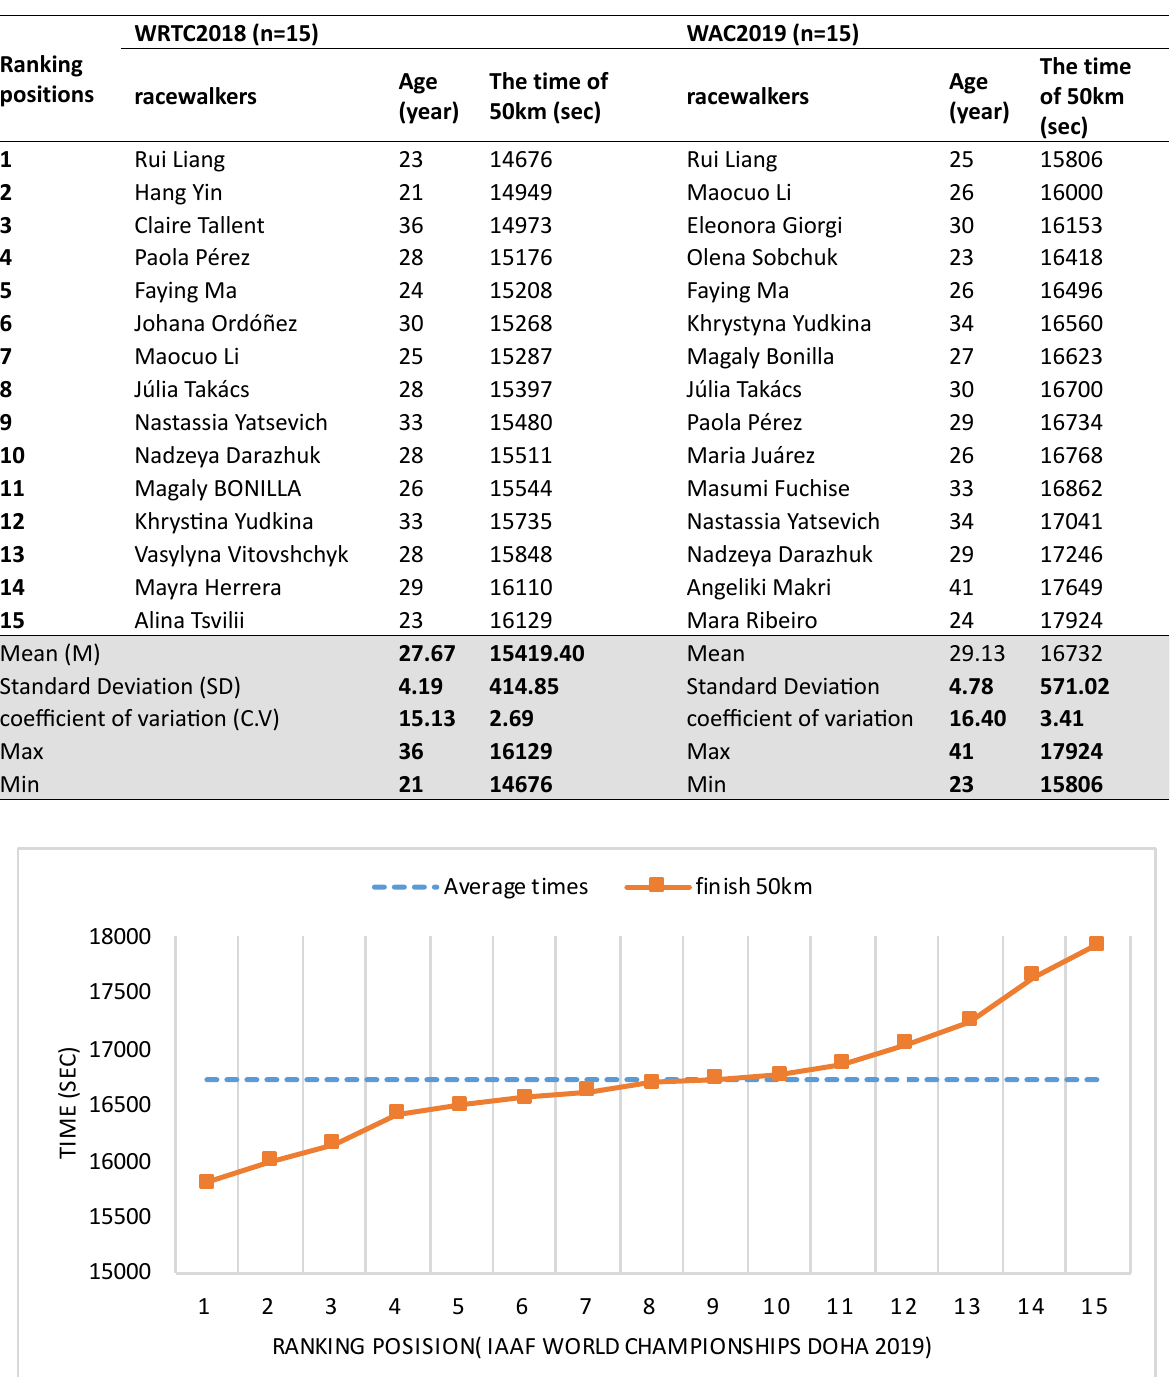
Table 5 and Figure 5 show correlation coefficients (r) between the performance times averages of the race stages and the final 50km in WAC2019 . It is noticed that so there was a direct correlation between all the stages of the race and each other. There is a strong positive correlation between all the stages and the final